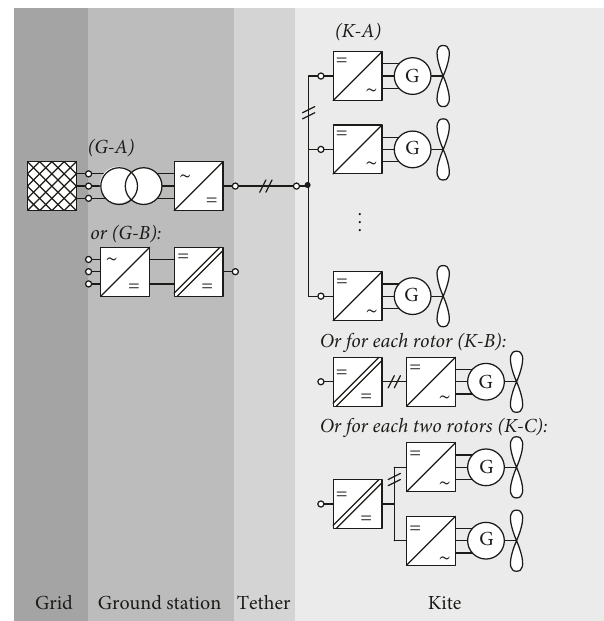
Figure 2: Power electronic topologies with DC transmission [5]: (G-A) grid connection via DC-AC converter and transformer; (G- B) grid connection via DC-DC converter with medium-frequency transformer and DC-AC converter; (K-A) medium-voltage genera- tors and AC-DC converters on kite; (K-B) low-voltage generators with low-voltage AC-DC converter and DC-DC converter with medium-frequency transformer; (K-C) the same as (K-B) but the DC-DC converter is connected to two low-voltage DC-AC converters and generators [5].